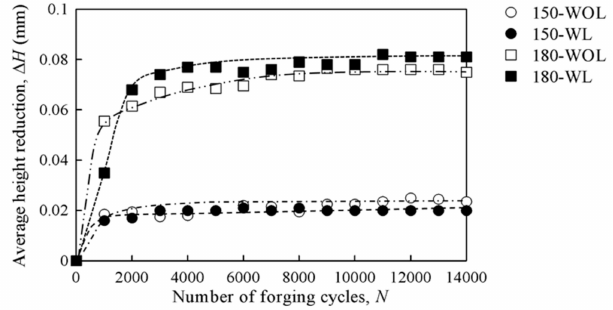
Figure 12. Variation in the specimen average height reduction by number of forging cycles. (150 / 180—Forging load (kN), WL—With Lubrication, WOL—Without